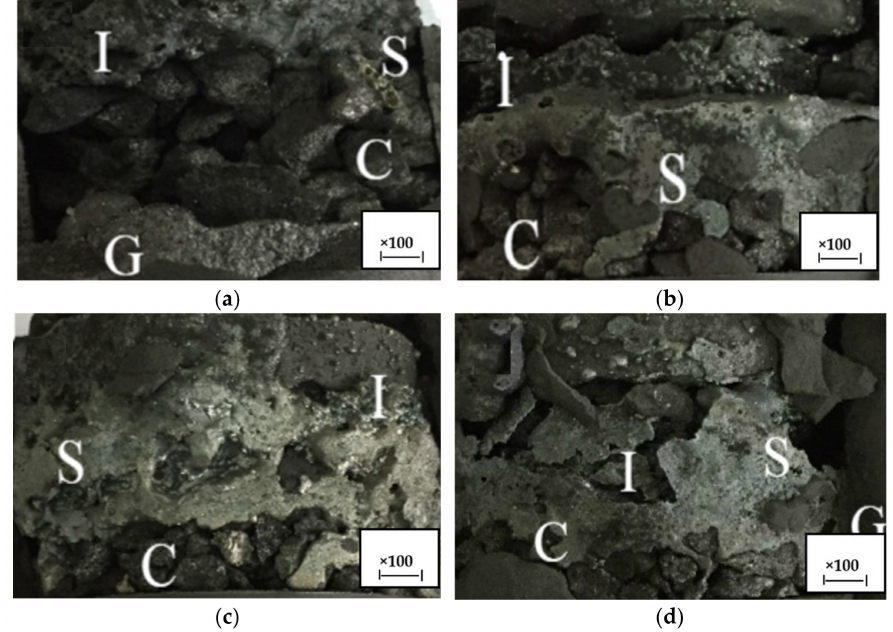
Figure 6. Distribution of iron and slag in nondropped materials in the graphite crucible. The symbols denote iron (I), slag (S), coke particles (C), and the graphite crucible (G). ( a ) H1-A; ( b ) H1-B; ( c ) H2-A;